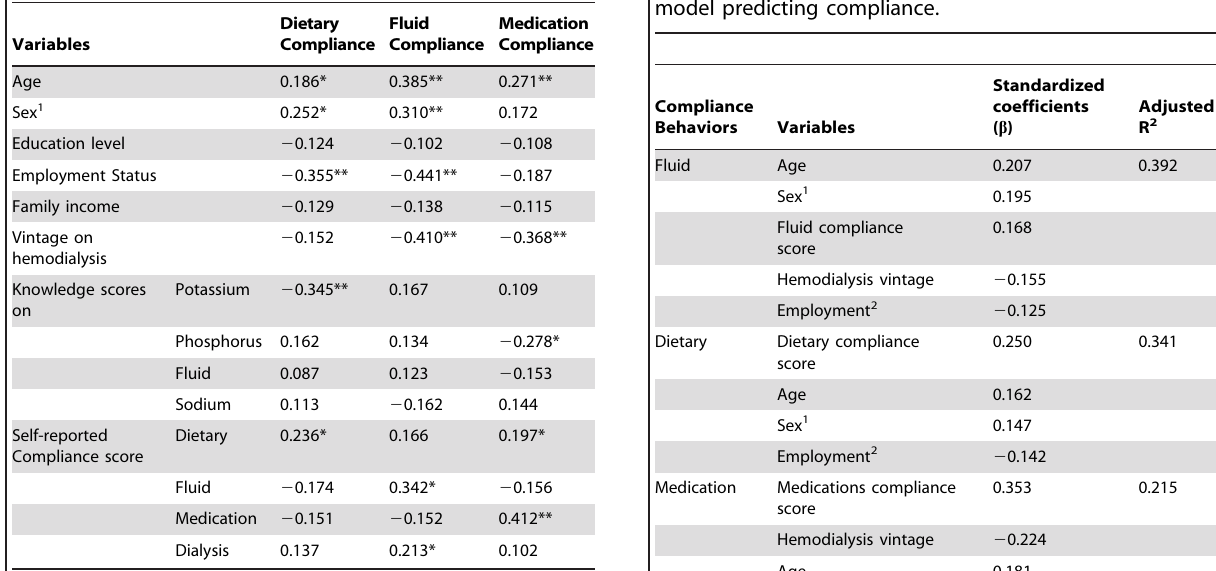
Table 6. Standardized coefficients of the linear regression model predicting